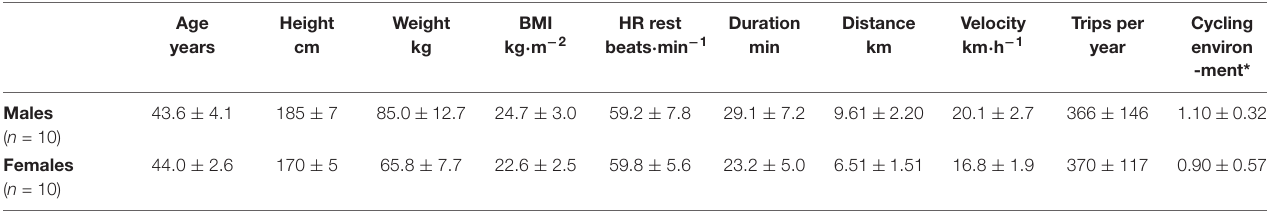
TABLE 1 | Characteristics of the commuter cyclists, their trips and cycling